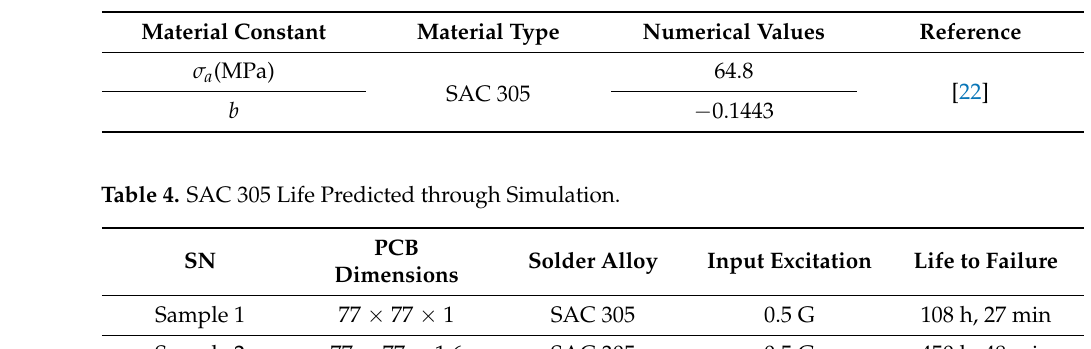
Figure 12. Maximum stress at the solder ball ( A ): 1 mm board, ( B ) 1.6 mm board, ( C ): 2 mm board, ( D ): elements for average stress. Table 3. Material Constant Values for Fatigue Life Estimation.